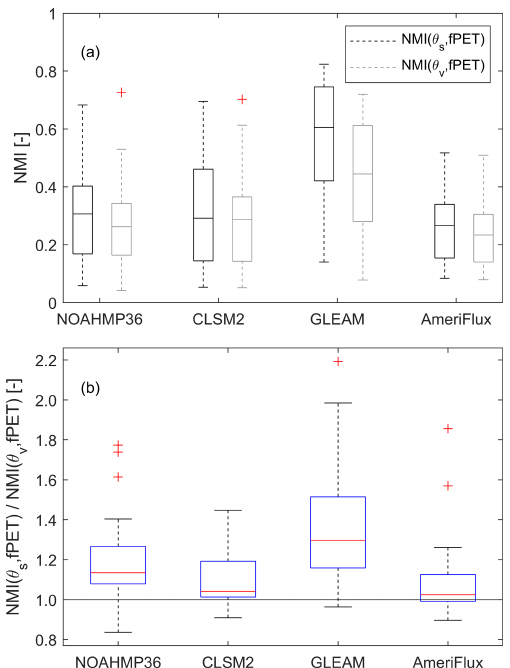
Figure 1. The θ / ET coupling strengths for summertime anomaly time series acquired from various LSMs, GLEAM and AmeriFlux measurements: (a) NMI( θ s , fPET) and NMI( θ v , fPET) individually and (b) NMI( θ s , fPET) normalized by NMI( θ v ,